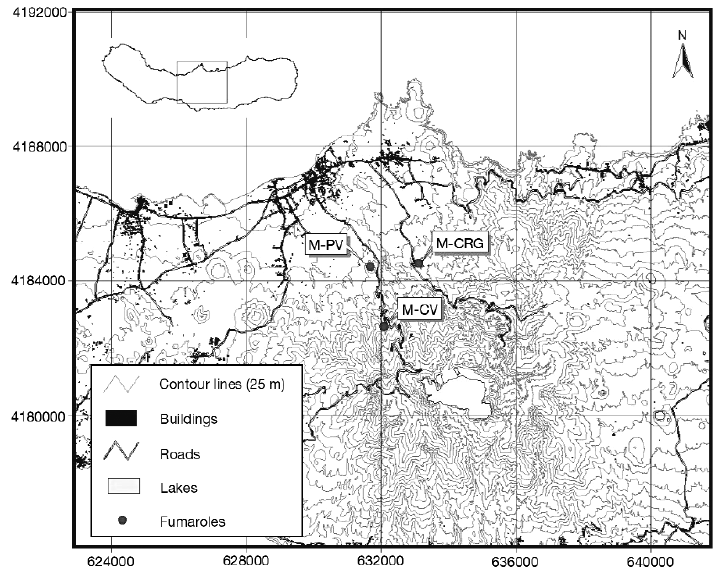
Fig. 3. Fogo volcano, S. Miguel Island, fumarolic fields (M-PV – Pico Vermelho; M-CRG – Caldeiras da Ribeira Grande; M-CV – Caldeira